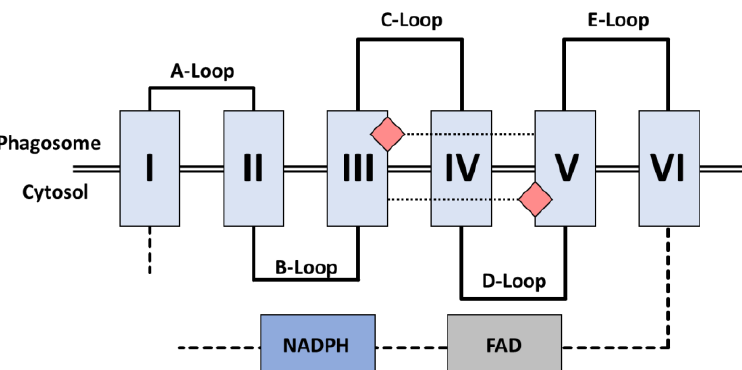
Figure 4. Organization of NOX2 transmembrane helices. Helices are numbered in the N to C direction. Two hemes are coordinated by conserved bis-histidyl motifs on helices III and V. ( B ) and ( D ) loops face the cytosol and contact the cytosolic DH domain. ( A , C , E ) loops face the extracytosolic space, which is equivalent to the interior of the phagosome, where oxygen reduction occurs.